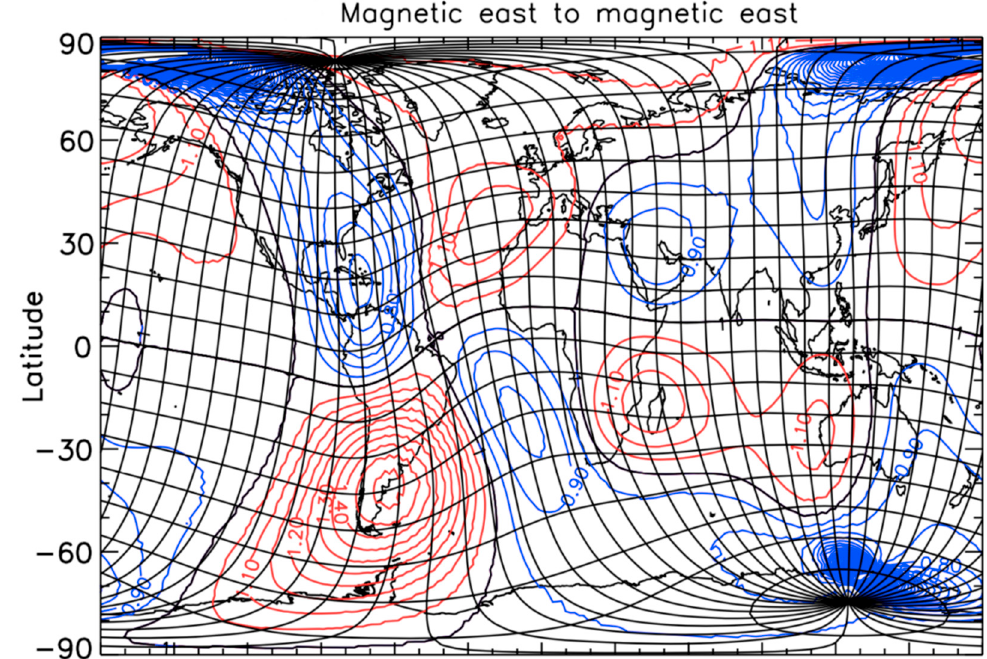
Figure 13. Map of the zonal velocity differences between conjugate locations. Represented here are the deviations from a purely dipolar mapping. Values greater than these idealized dipolar values are plotted with red contours, while values less than the dipolar values are plotted with blue contours (adapted from [30]).